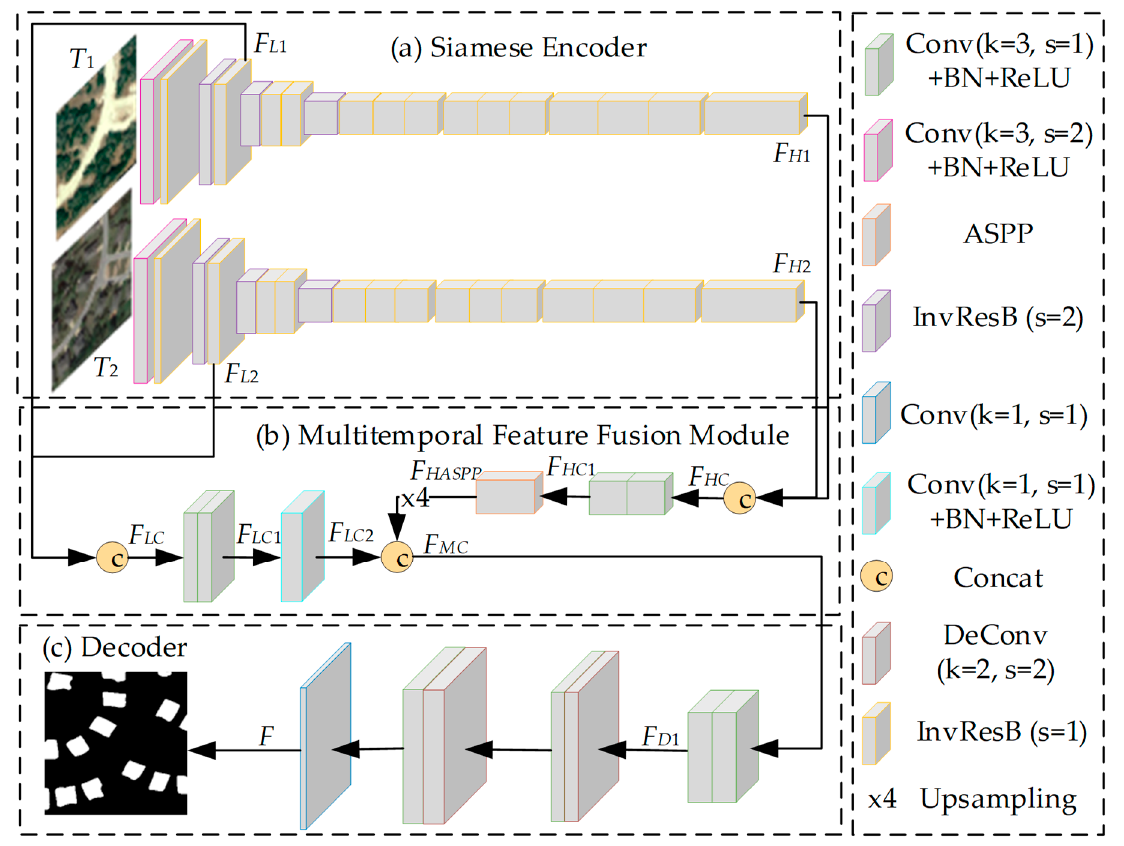
Figure 3. The architecture of the proposed lightweight Siamese network. ( a – c ) show the Siamese encoder, the multi-temporal feature fusion module and the decoder, respectively. ‘s’ denotes the stride, ‘k’ denotes the kernel size, ‘Concat’ is the concatenation operation, ‘Conv’ denotes convolution, and ‘DeConv’ stands for deconvolution. The term ‘ASPP’ refers to the atrous spatial pyramid pooling. InvResB represents ’the inverted residual bottleneck’.